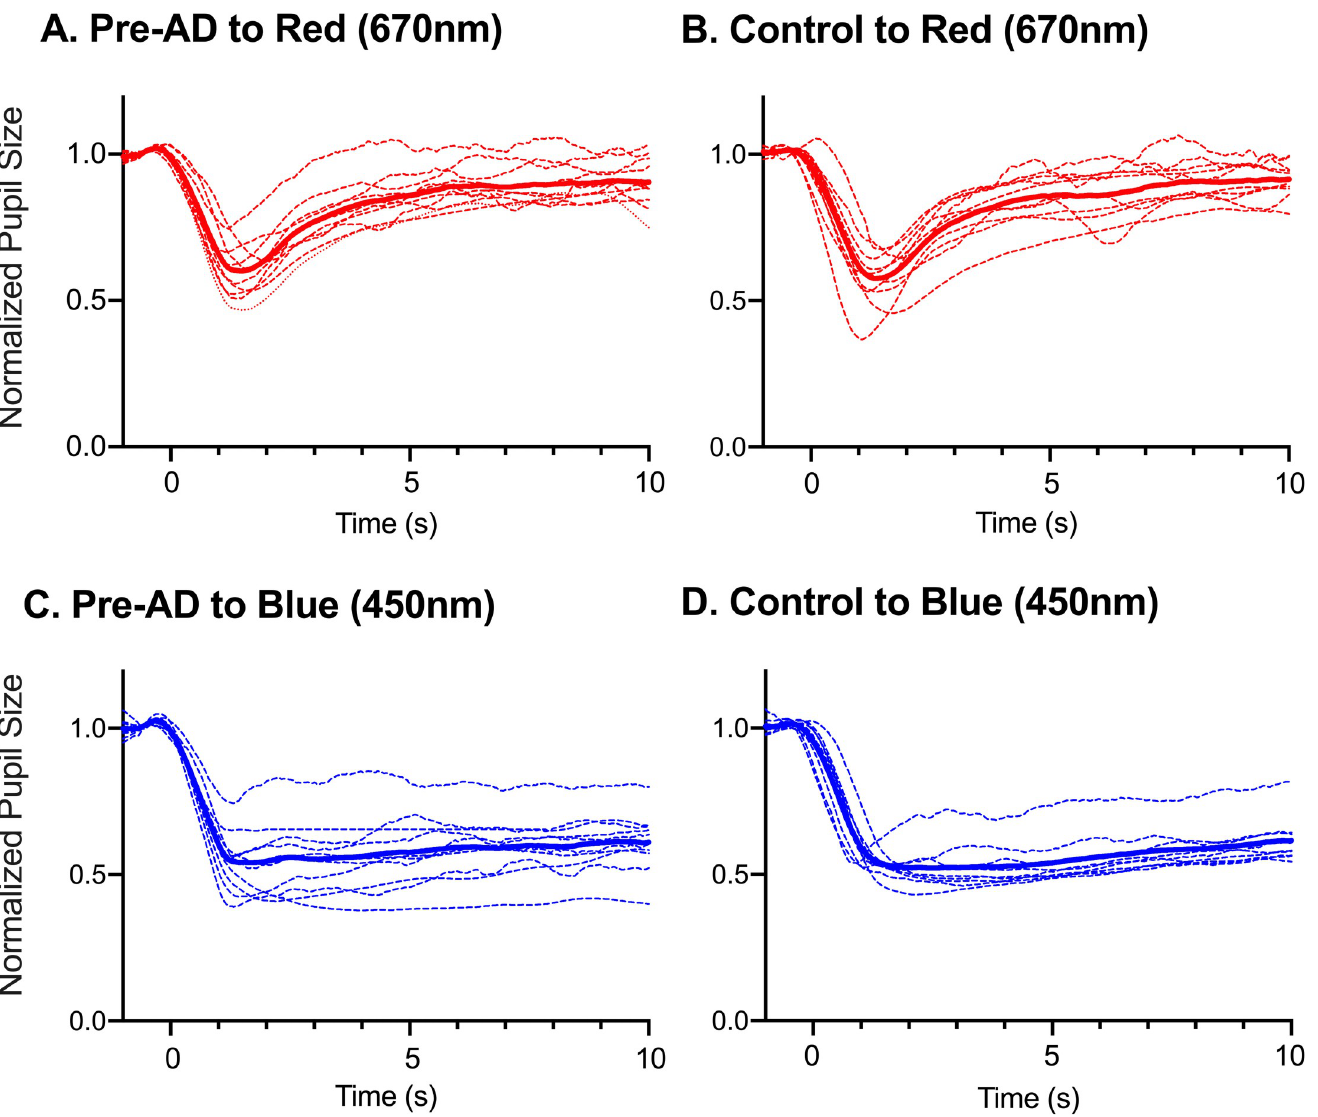
Fig 1. Normalized pupillary light response (PLR) following photopically matched red (620 nm) and blue stimuli (450nm) at 250 or 2.3 log cd/m 2 . (A) Following the red stimulus, individual normalized PLRs of pre-AD individuals (n = 10, dashed red) and the average pre-AD PLR (solid red). (B) Individual normalized PLRs in controls (n = 10, dashed red) and the average control PLR (solid red). (C) Following the blue stimulus, individual normalized PLRs of pre-AD individuals (n = 10, dashed blue) and average pre-AD PLR (solid blue). (D) Individual controls (n = 9, dashed blue) and the average control PLR (solid blue). Pre-AD, pre-symptomatic Alzheimer’s